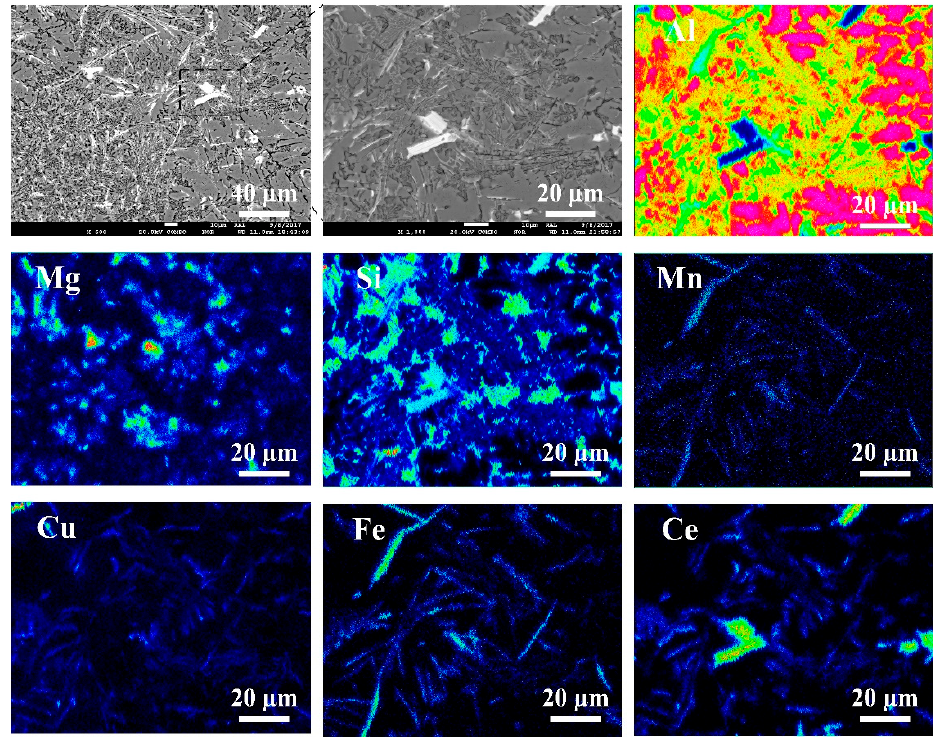
Figure 5. The electro-probe micro (EPMA) images of element distribution in the centerline segregation band region of twin-roll cast sheets.